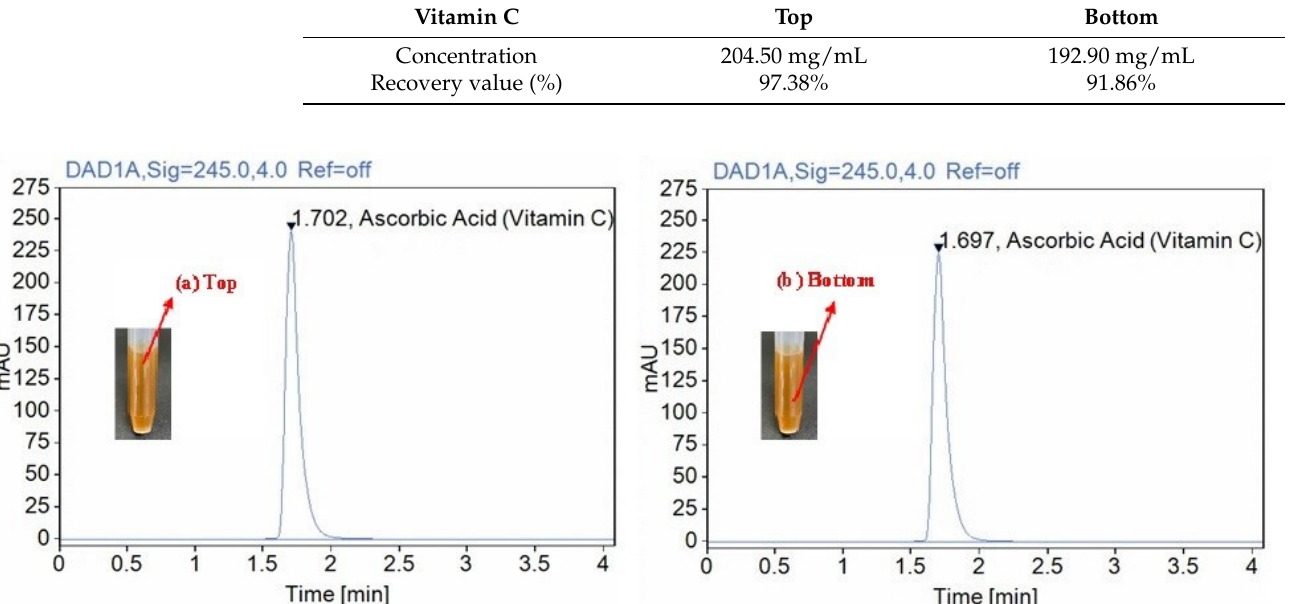
Table 2. Concentrations from top and bottom layer of liposomal vitamin C.